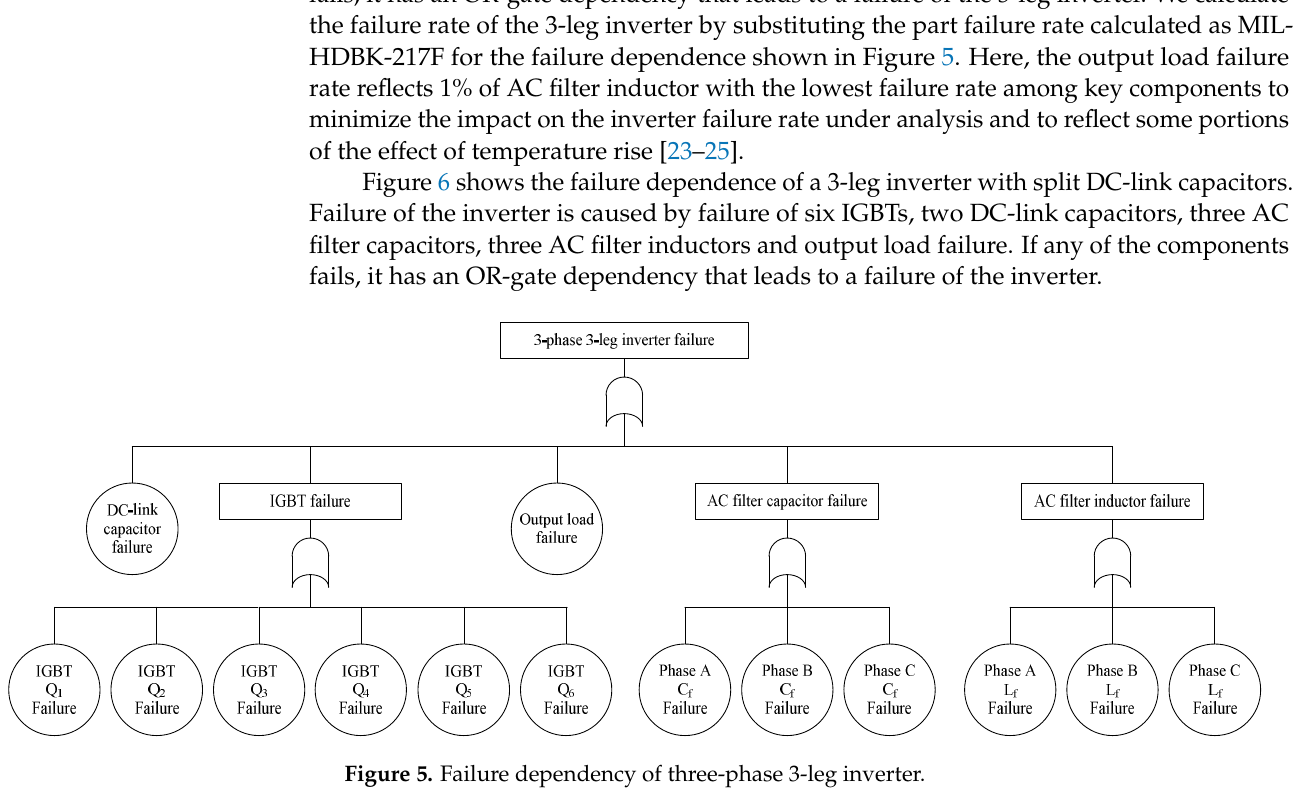
Figure 5. Failure dependency of three-phase 3-leg inverter.